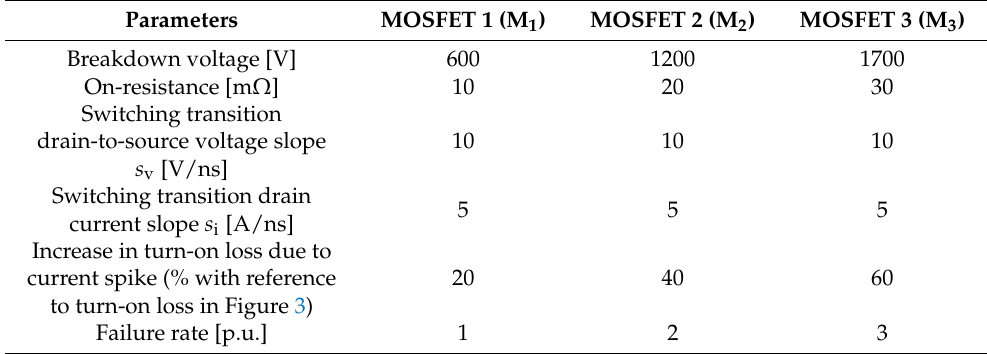
Table 2. SiC MOSFET parameters, set from the parameters given by SiC MOSFET manufacturers [15,16].